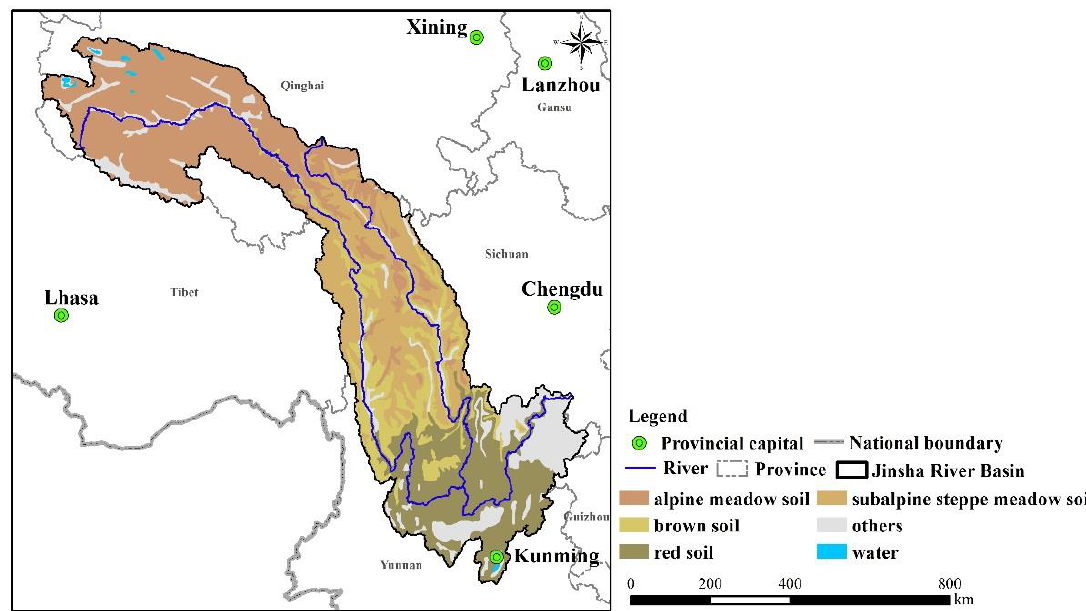
Figure 5. Soil distribution in JRB.